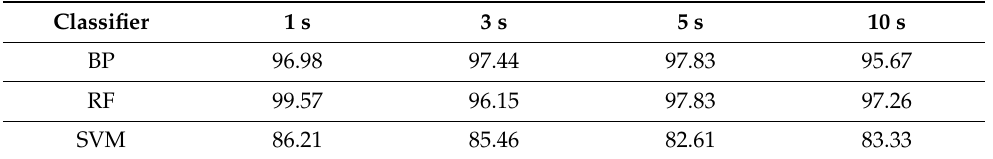
Figure 12. The average percentages of the classification accuracies over both these 12 participants performing the various activities yielded by both our proposed method and the traditional methods with different classifiers under the immersion state.